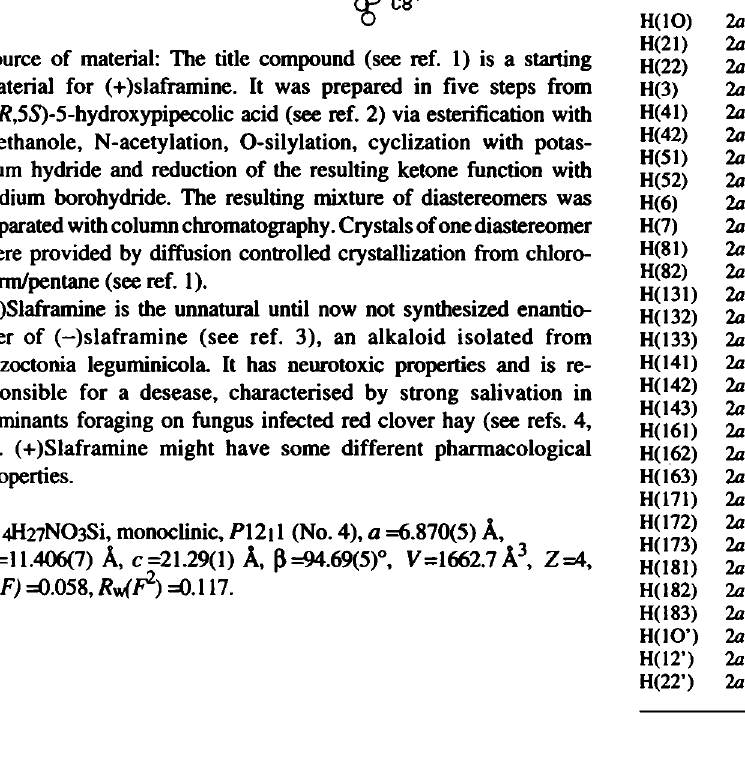
Table 2. Final atomic coordinates and displacement parameters (in Â 2